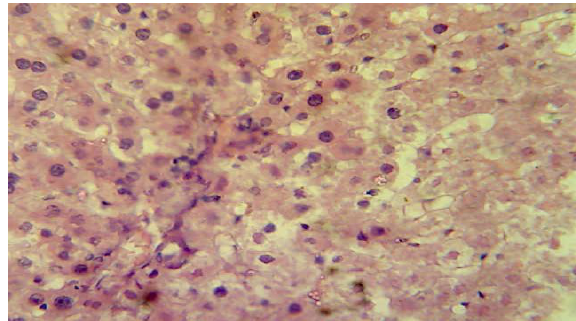
Figure, 10. In section of histopathology in the liver of rat receiving 1mg/kg B.W of acrylamide for 65 days in (G3 group): showed Coagulative necrosis of hepatocytes separated from normal tissue by inflammatory reaction (H.& E.stain